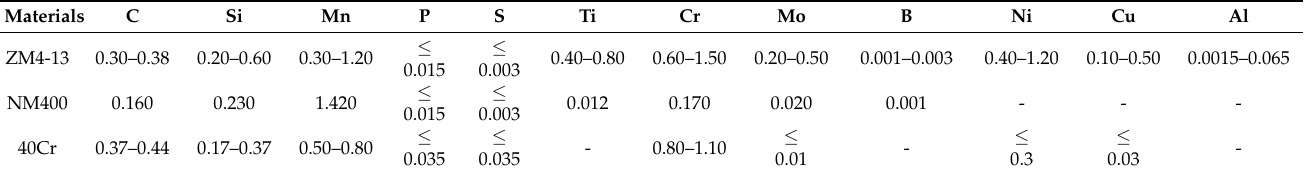
Table 1. The chemical composition of experimental materials